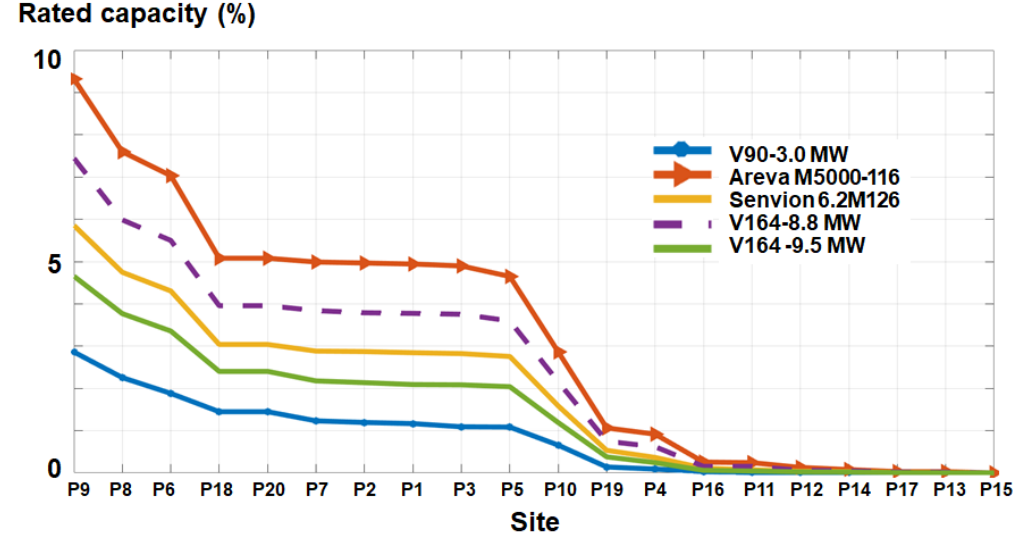
Figure 8. The rated capacity (in %) of the wind turbines which may operate in the Black Sea area. Results based on the ERA-Interim data covering the interval January 1998–December 2017.